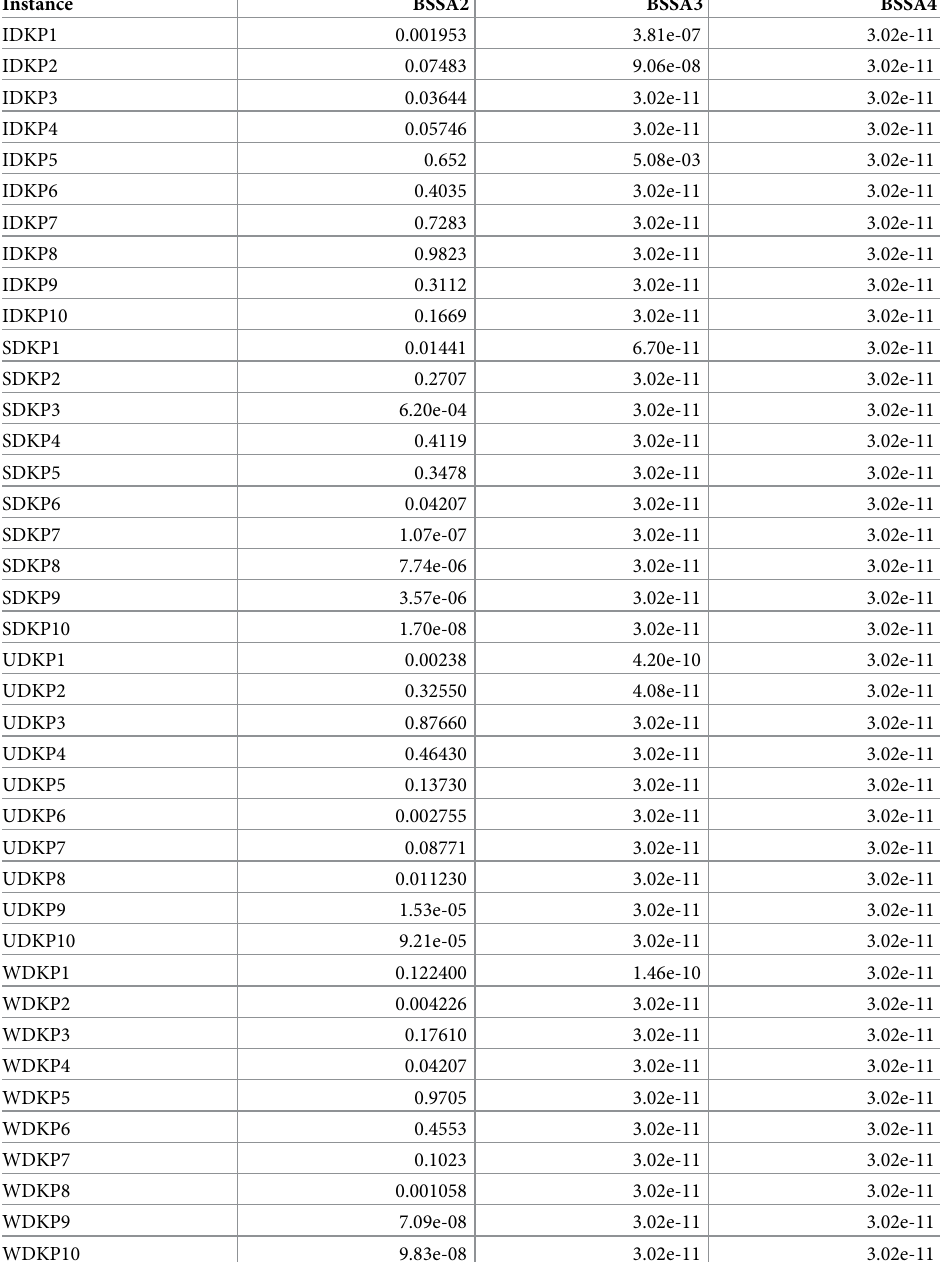
Table 3. p -values returned from the Wilcoxon rank sum test among BSSA1 with other proposed algorithms. Instance